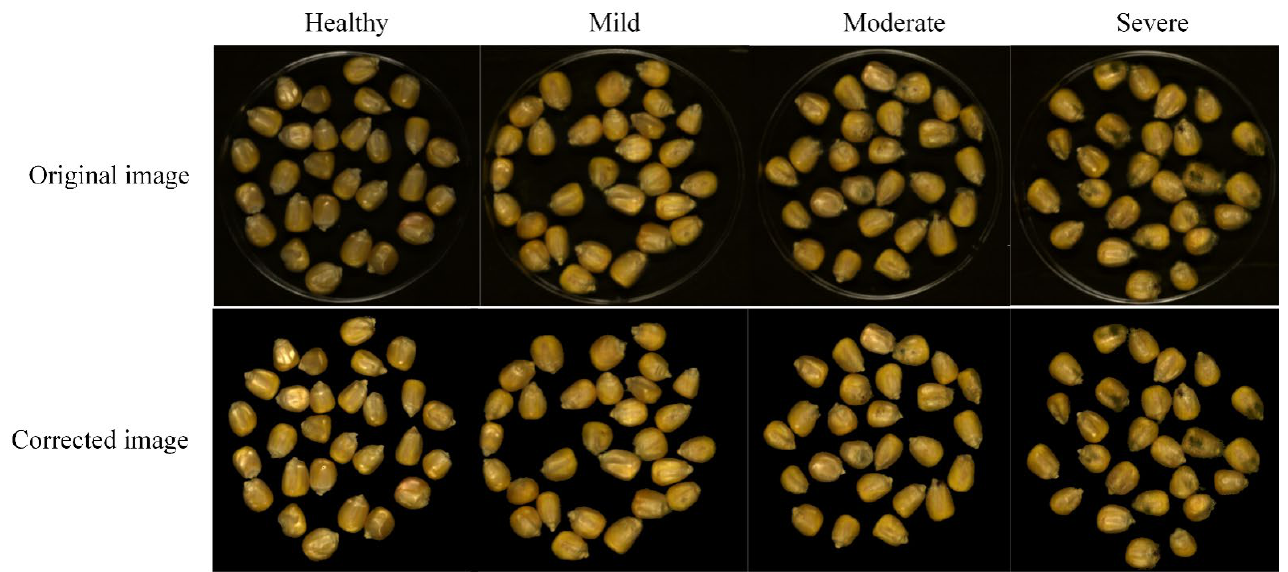
Figure 2. Original and denoised RGB images (red, green and blue three-channel color image) of maize with different mold levels.